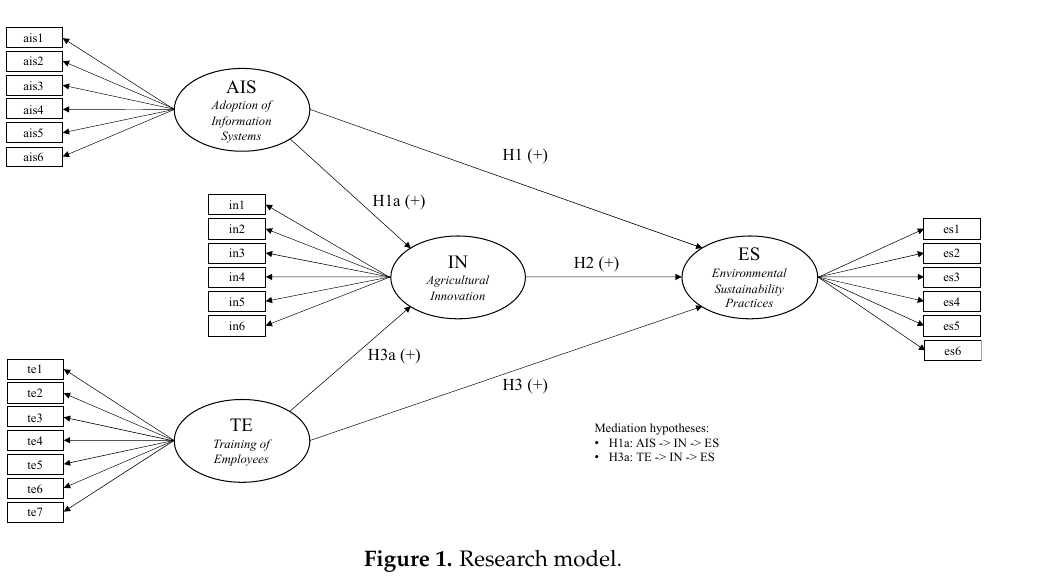
Figure 1. Research model.